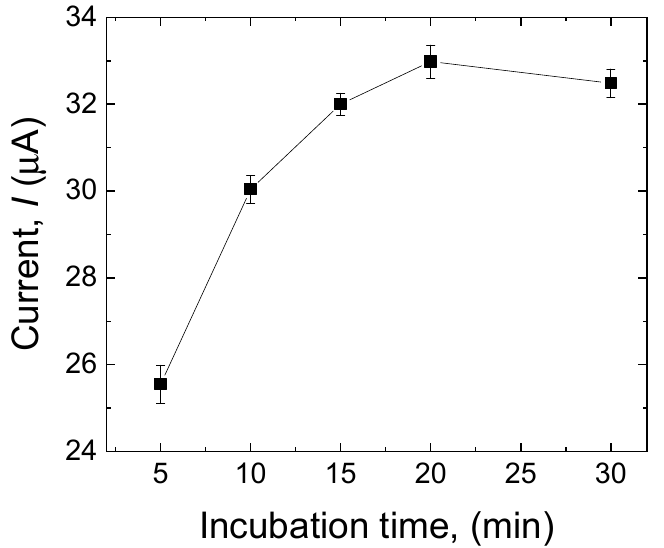
Figure 6. Effect of incubation time (5 min, 10 min, 15 min, 20 min, and 30 min) on the current response of the sensor to MDA (500 µM). Error bars are calculated from three independent replicates.